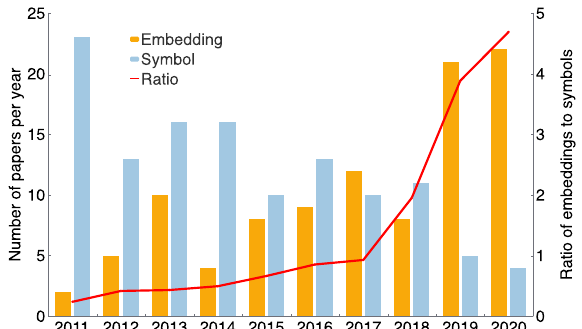
Fig. 18 Number of papers applying symbol-based representation or embedding-based representation and the ratio between them over the last decade in ACL, WWW, and KDD. The line is smoothed by taking a 3-year average. Detailed settings where we selected these papers are shown in Section